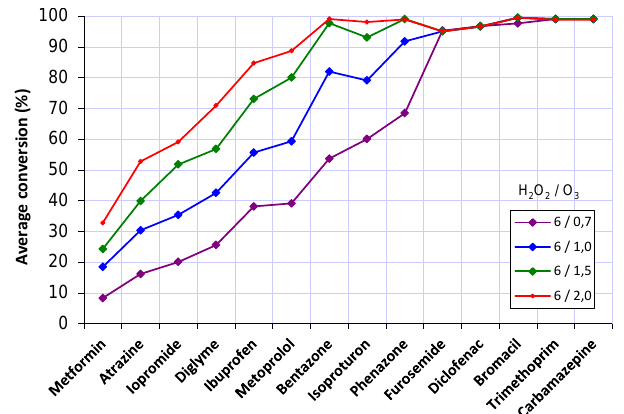
Figure 9. Average ( n = 14) conversion in percentages of model compounds as function of ozone dosage at a hydrogen perox- ide concentration of 6mgL − 1 in the period August 2011 till March